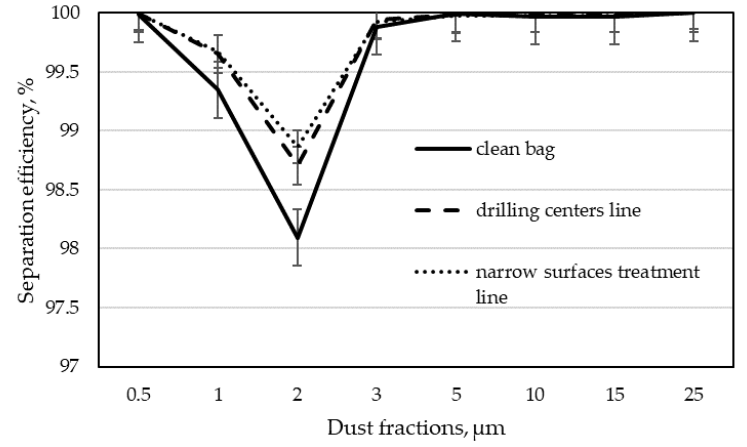
Figure 6. Fractional separation efficiency for 272 days of operation time of filter bags in individual dust extraction installations.